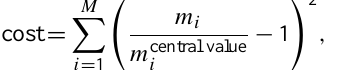
erations, obtained from the idealized pseudo-function experiments.